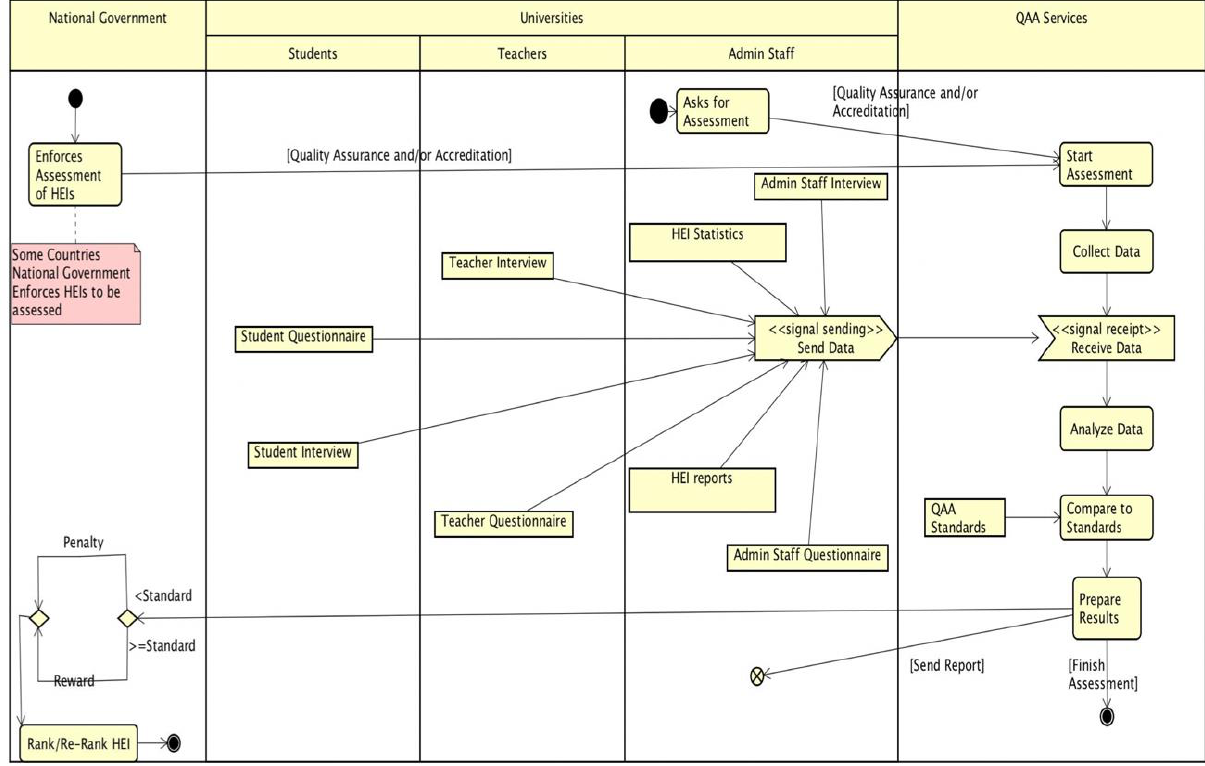
Figure 1 overviews of QAA agencies operational processes and their interactions with key stakeholders.